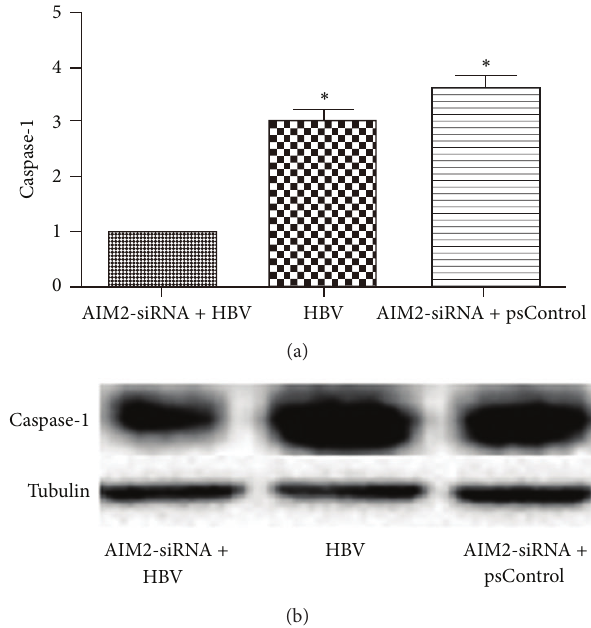
Figure 3: Down-regulation of AIM2 reduced expression of caspase- 1 at the post-transcriptional level (a) and at the translational level (b). HGM cells were divided into three groups: AIM2-siRNA and HBV DNA co-transfected group (group A), HBV DNA-transfected group without AIM2-siRNA(group B) and AIM2-siRNA and empty plasmidsco-transfectedgroup(groupC).Theexpressionofcaspase- 1 in group A detected by qRT-PCR decreased in 1.9, 2.4 folds respectively compared with group B and group C (a). These changes were also noted at the translational level, as measured by Western blot (b). ∗ indicates a significant difference compared with the control ( 𝑃 < 0.01 ). 𝑛 = 3 independent experiment RNA samples for each